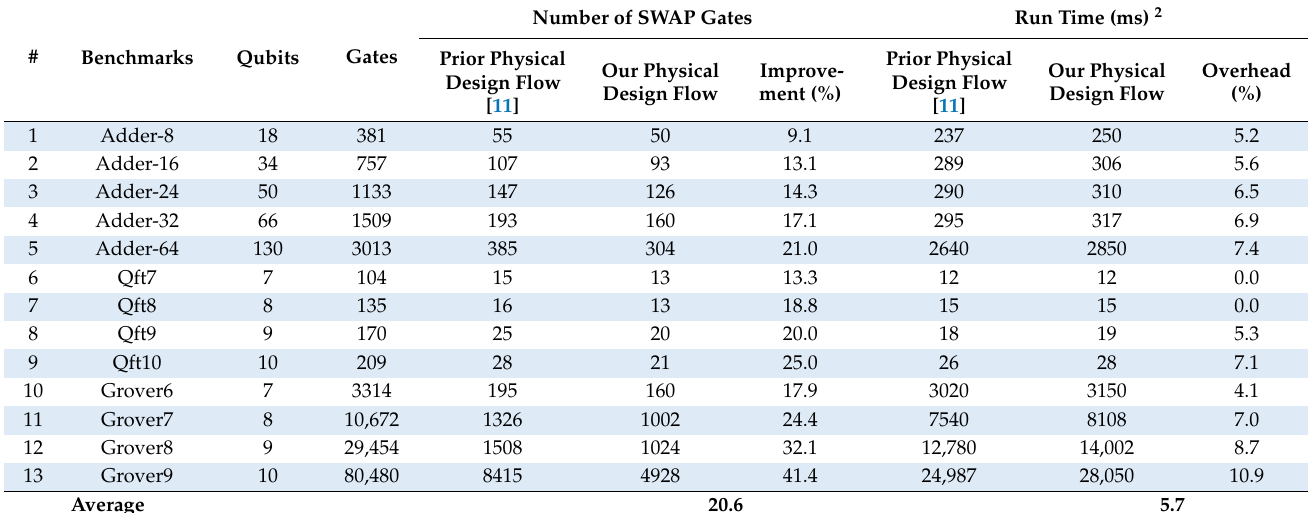
Table 1. The results achieved by prior physical design flow and ours for the attempted benchmarks 1